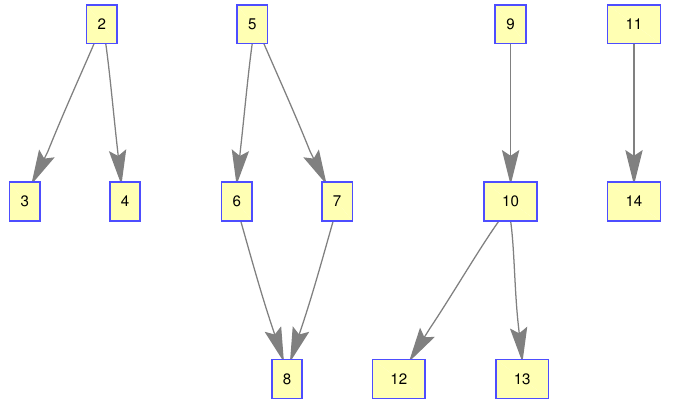
Figure 6. The structure of subgroup targets during k = 30 and k =